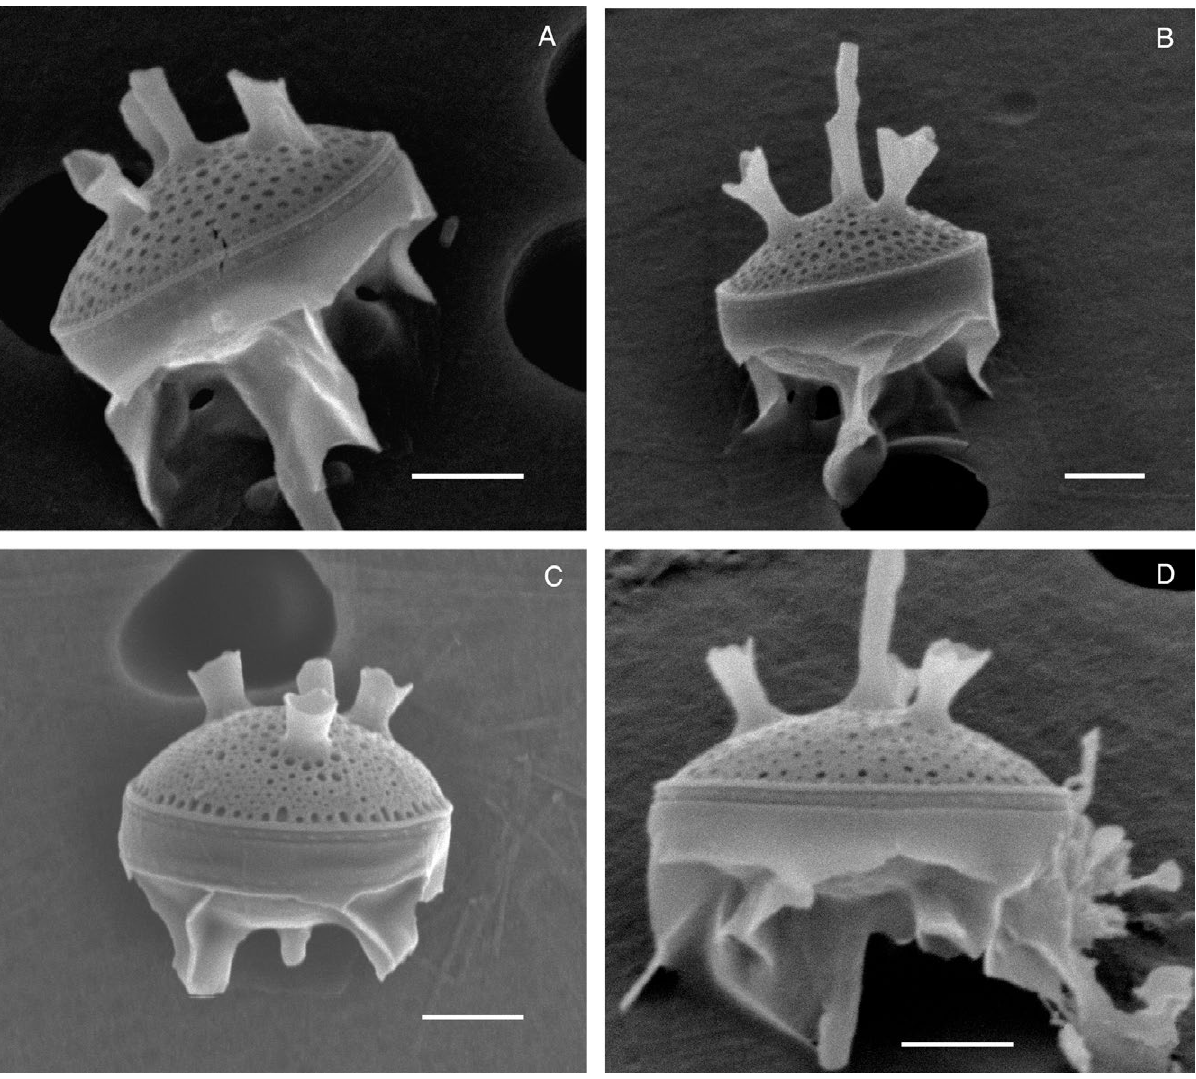
Fig. 3. – Girdle (side) views of Minidiscus comicus showing the varying degrees of doming of the valves. A, B, D, 11 May 2009; C, 21 March 2009. Scale bar 1